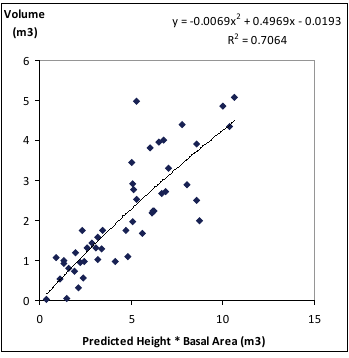
Figure 4: Volume vs. predicted